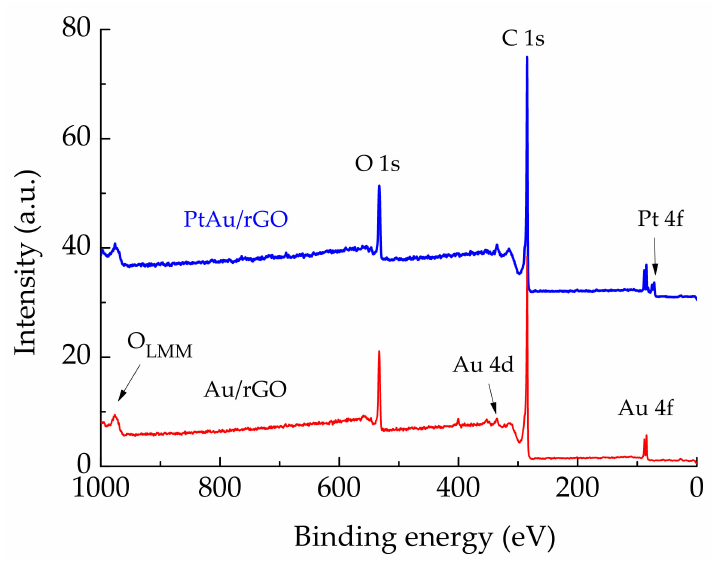
Figure 3. Survey spectra for rGO supported Au and PtAu nanoparticles.